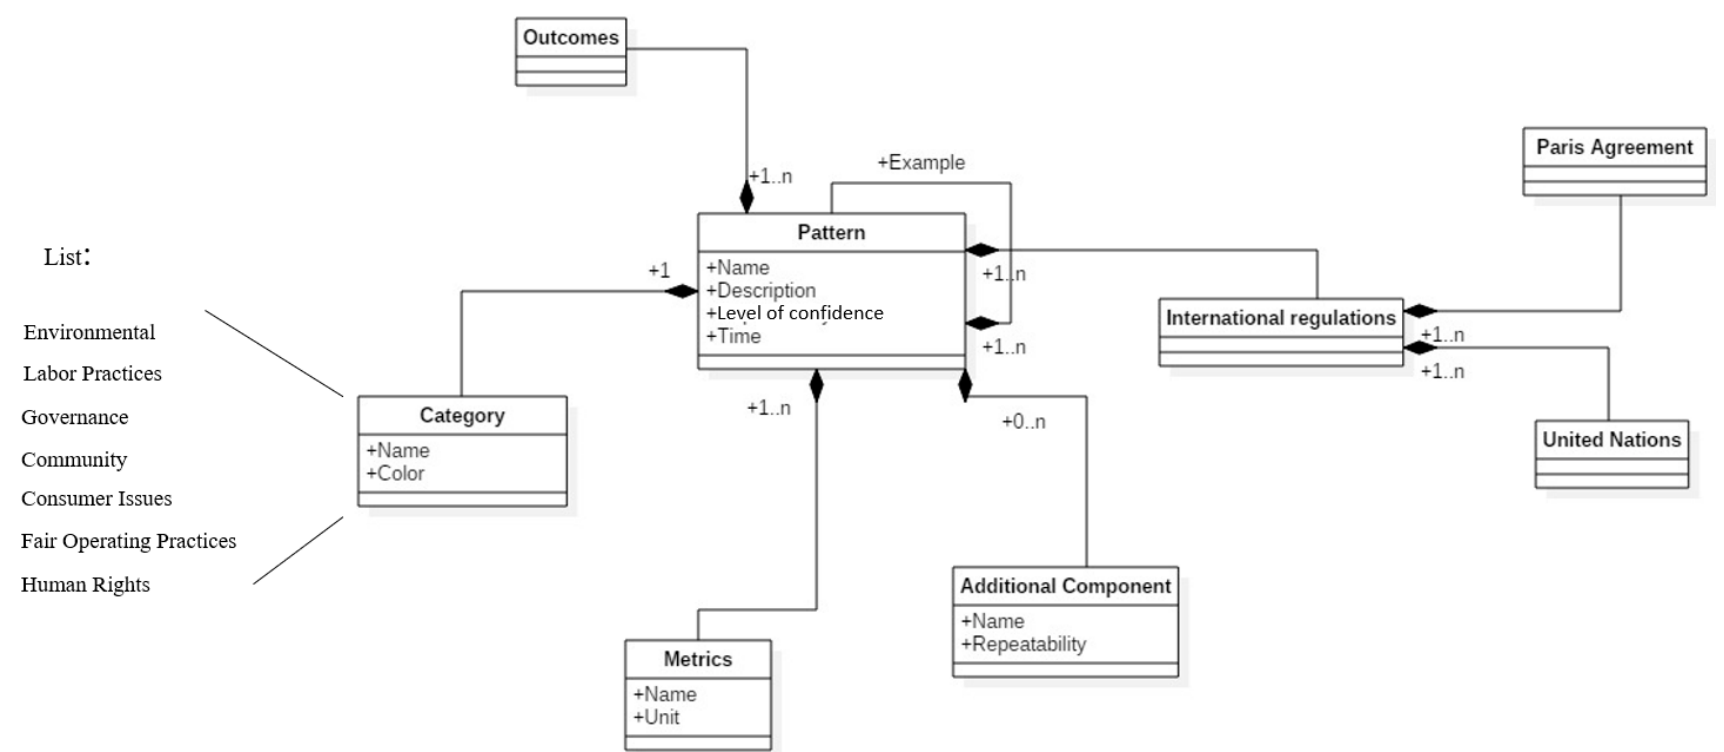
Figure 2. UML representation of the pattern structure.